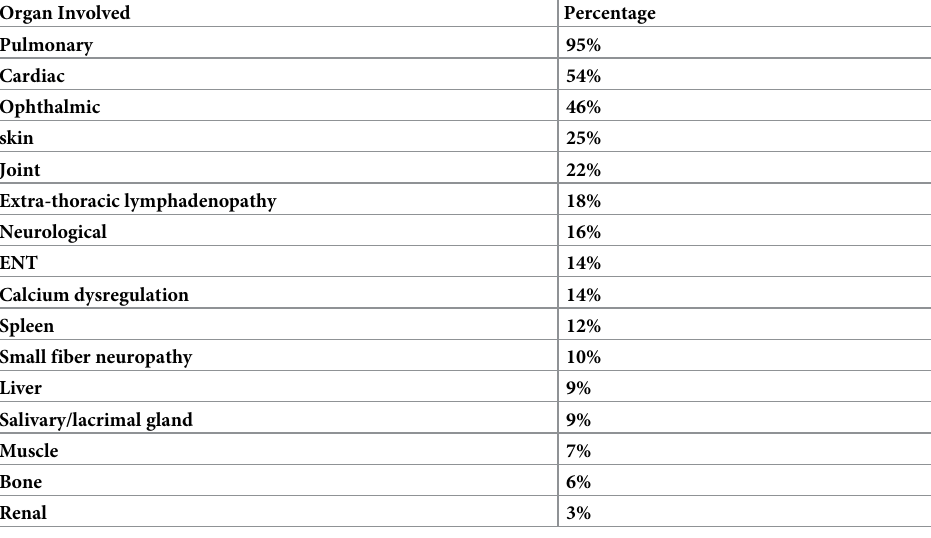
Abbreviations: ENT: Ear, nose and